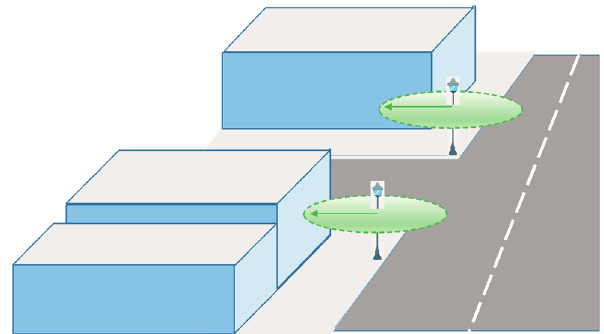
Figure 5. Installation and sensor coverage